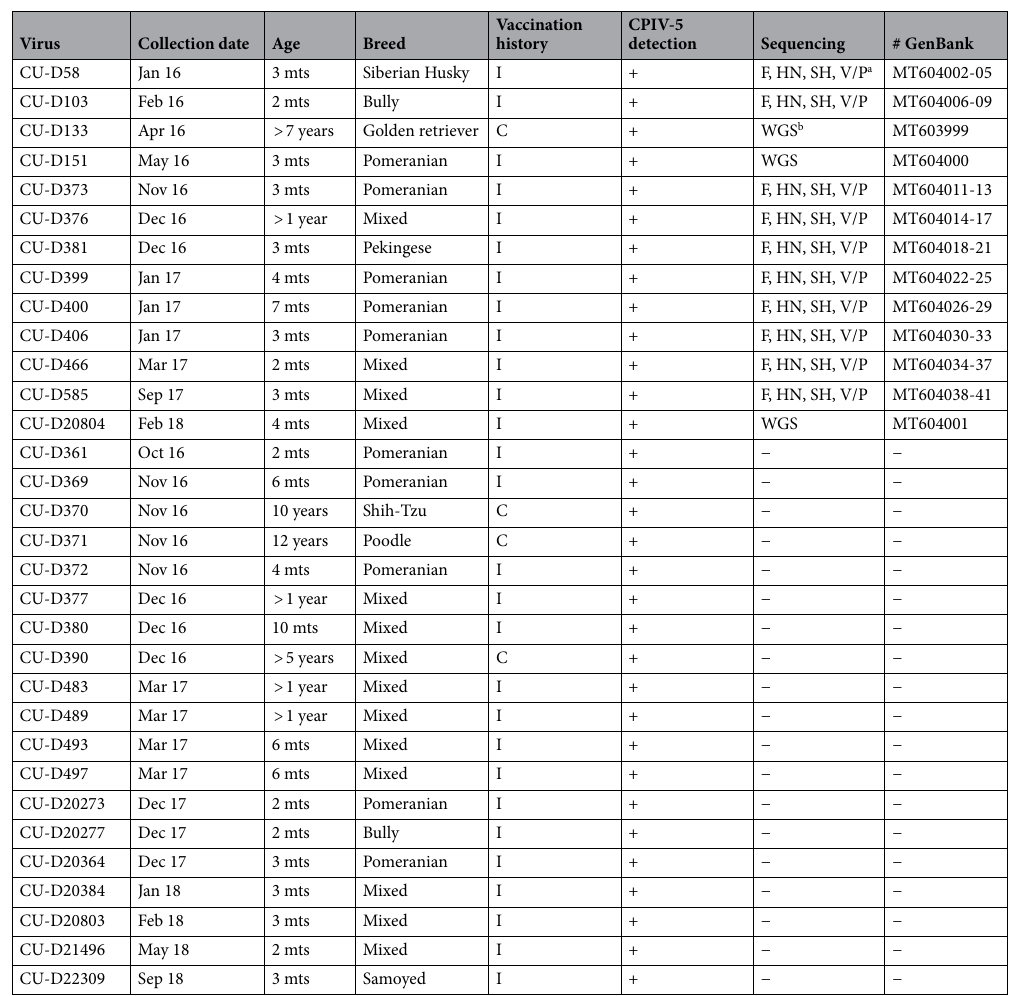
Table 1. Description of canine parainfluenza type 5 (CPIV-5) characterized in this study. C complete vaccination, I incomplete vaccination. a F, HN, SH, V/P; F, HN, SH, V/P gene sequencing. b WGS; whole genome